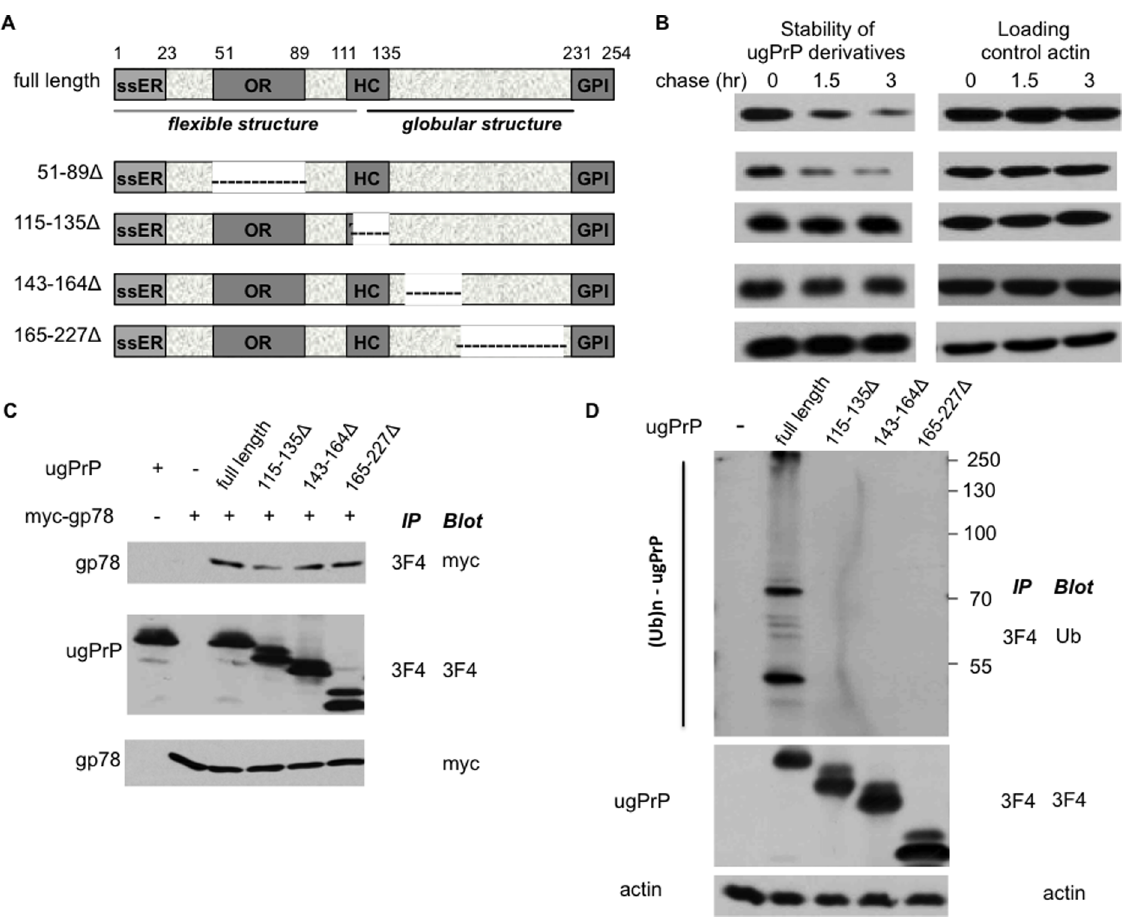
Figure 4. The C-terminal sequences are critical for ugPrP ubiquitylation and turnover. ( A ) Domain structure of PrP and various deletion mutants constructed. Four domains (i.e, ssER, OR, HC, GPI) are indicated. NMR analysis demonstrated disorder structure for the N-terminal segment and globular structure for the C-terminal half of PrP. The deleted portions are shown as dashed lines. ( B ) The effects of various deletions on ugPrP stability. Degradation kinetics of wild-type ugPrP and mutants (left panels) in HEK293 cells was assayed as described in Figure 1. Actin serves as the loading control (right panels). ( C ) The C-terminal deletions maintain efficient gp78-binding. The interaction between gp78 and and ugPrP derivatives was assessed as described in Figure 2A. ( D ) Deletions of C-terminal sequences impair ugPrP ubiquitylation. The ubiquitylation pattern of ugPrP derivatives in HEK293 cells was determined as described in Figure 3E after MG132 treatment.